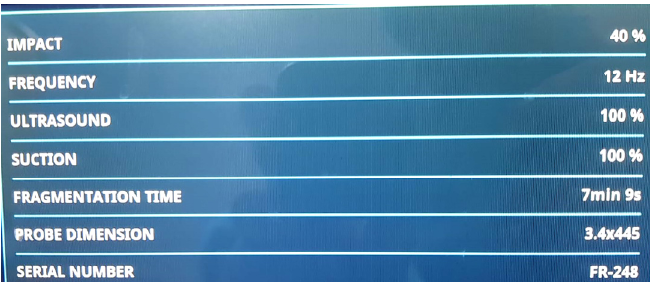
Figure 2. The control panel of the Trilogy device. Table 1. Patient and stone Table 2. Intervention times and clearance rates in the Trilogy group.